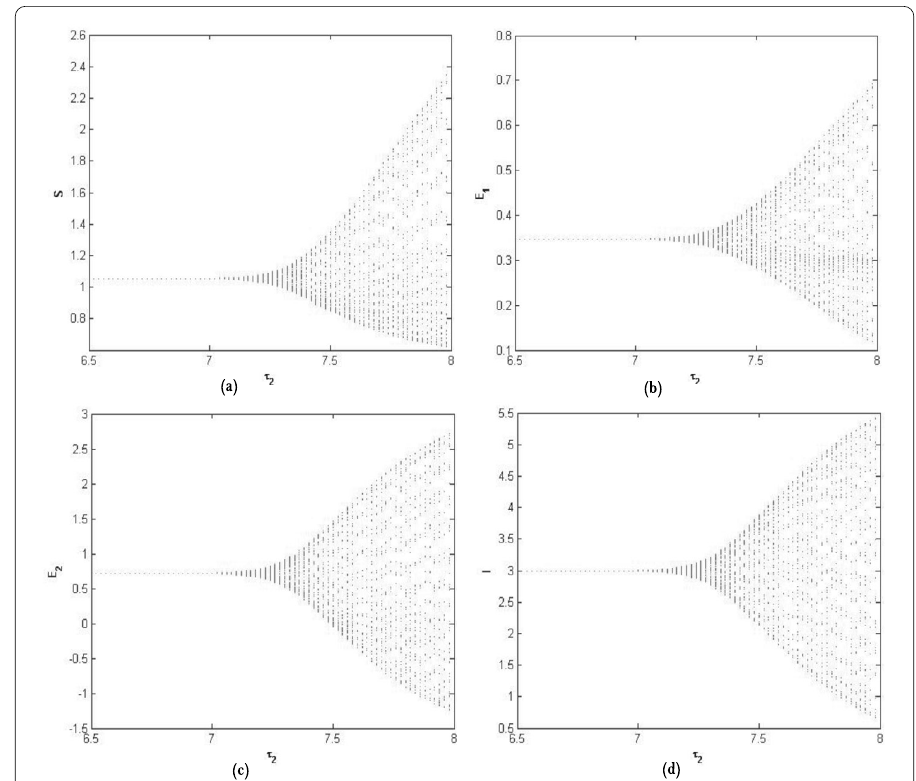
Figure 4 The bifurcation diagram with respect to τ 2 when τ 1 = 2.25 ∈ (0, τ 10